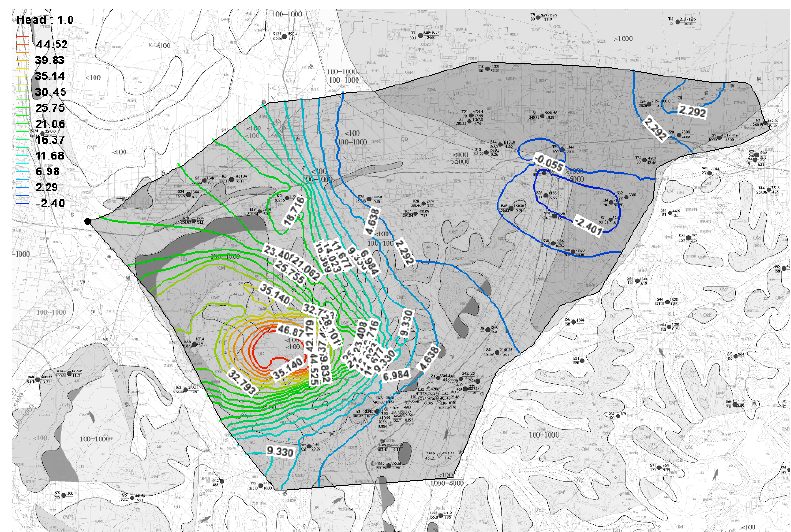
Figure 5. Computational flow field diagram of the research area in 2017.